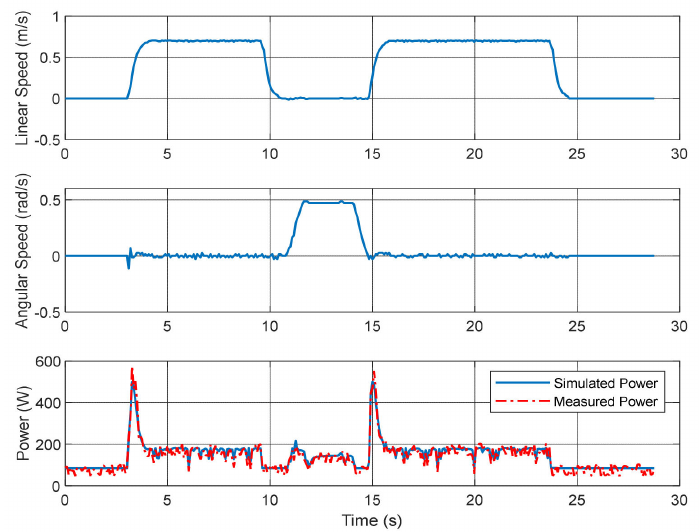
Figure 3. Comparison between simulated and measured power